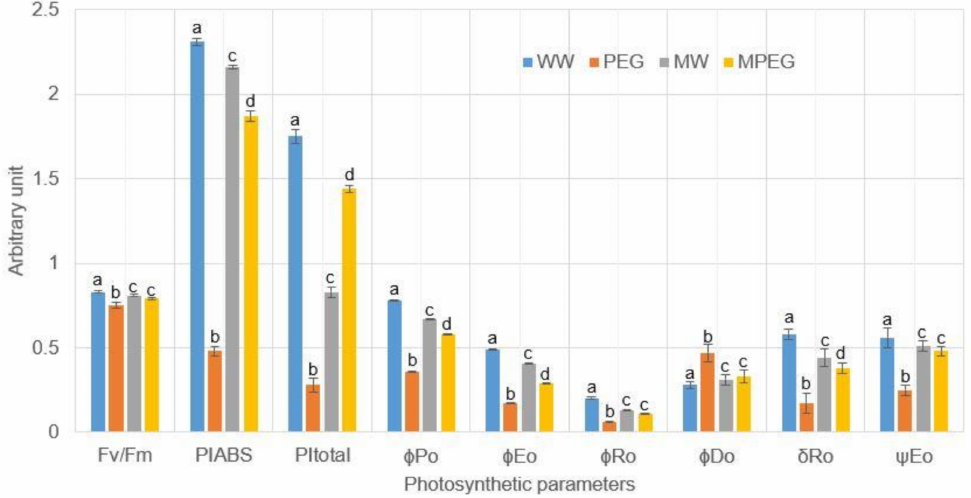
Figure 7. E ff ect of melatonin application on oat plants under PEG-induced osmotic stress analyzed by JIP-test parameters. The details of each parameter are given in Supplementary Table S1. Values are the mean ± SE of three independent assays of four replicates in each treatment. Di ff erent letters in each row indicate significant di ff erences ( p ≤ 0.05) between treatments; Tukey’s test ( n = 9). WW, well-watered oat plants (control); PEG, oat plants exposed to 20% PEG for 7 days; MW, oat plants exposed to melatonin for 7 days then watered normally for 10 days; MPEG, plants treated with melatonin for 7 days then exposed to 20% PEG for 10